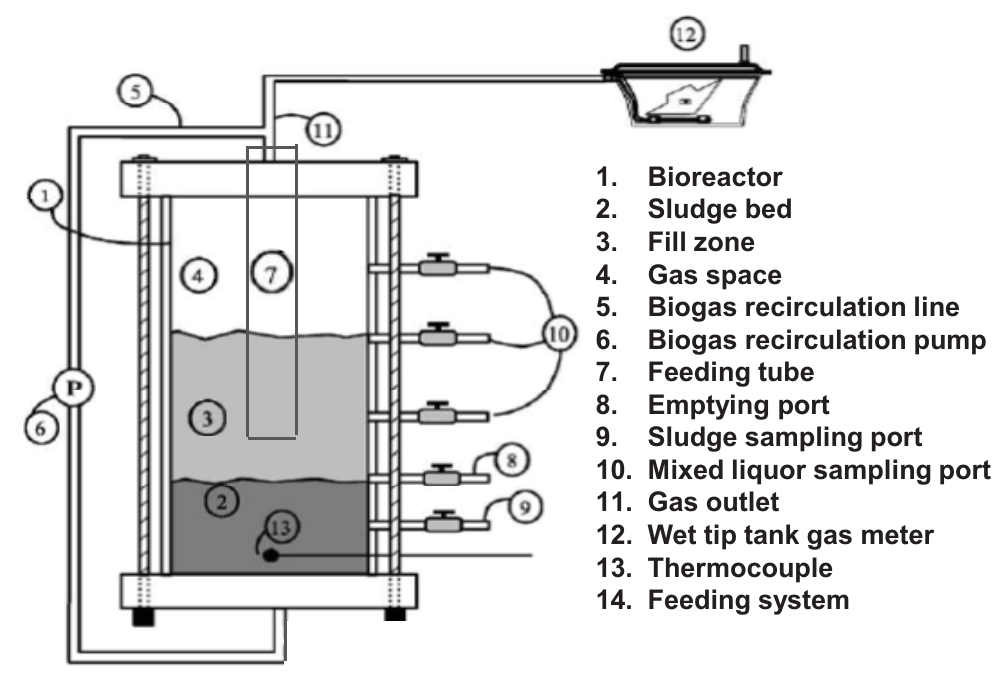
Figure 1. Schematic diagram of the sequence batch reactor.